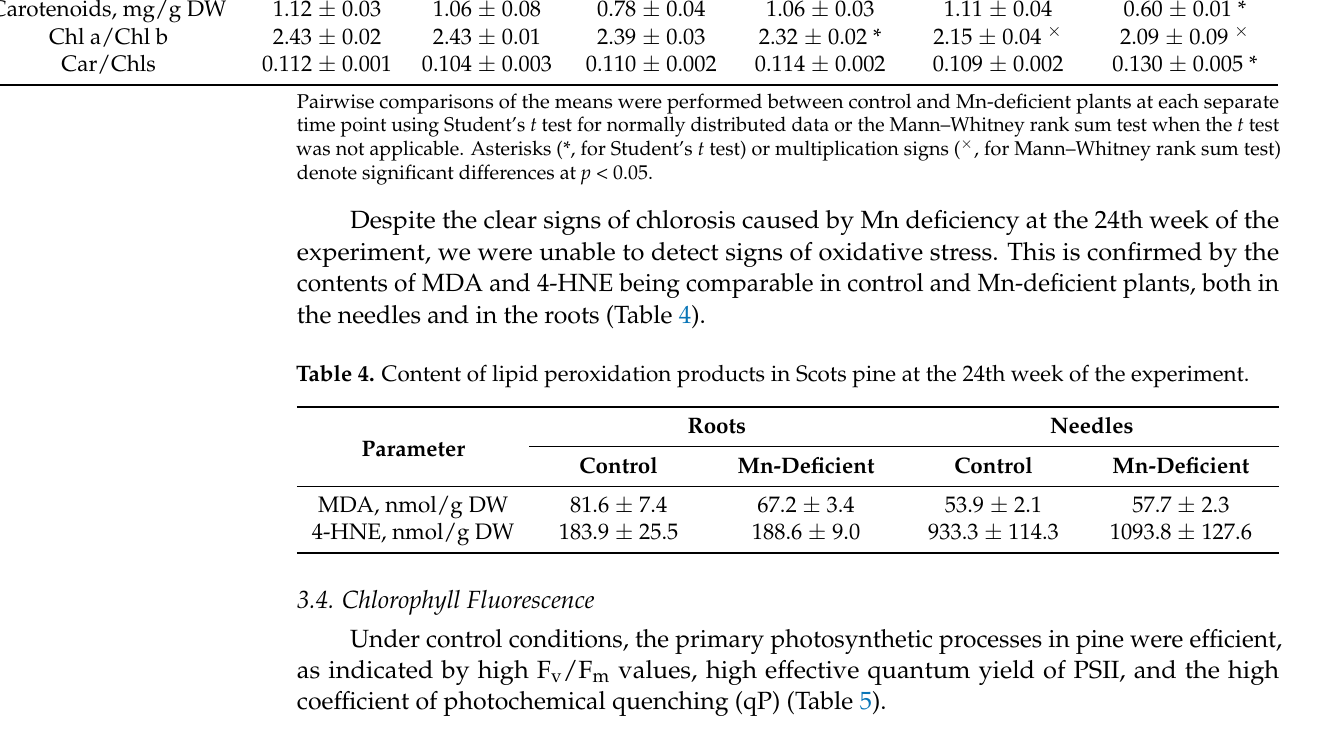
Table 5. Chlorophyll fluorescence parameters of needles at the 24th week of the